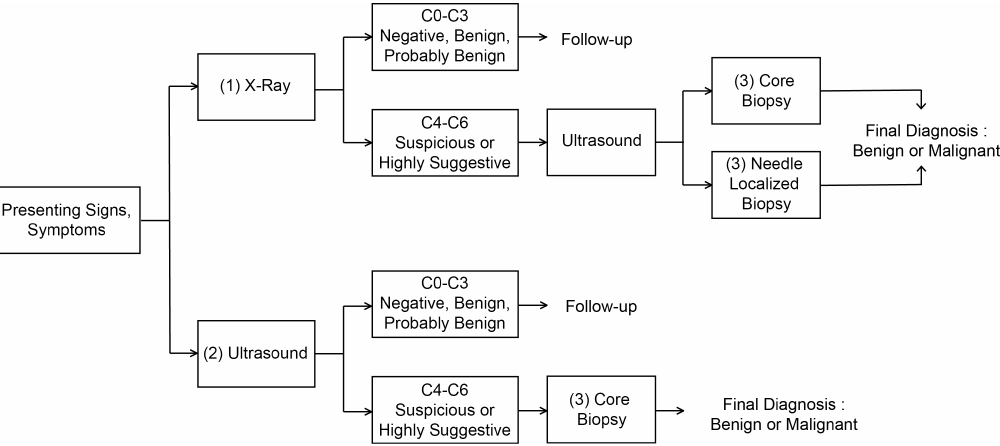
Figure 1. Process of breast cancer